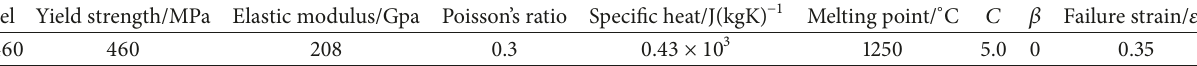
Table 2: Parameters used in state equation of